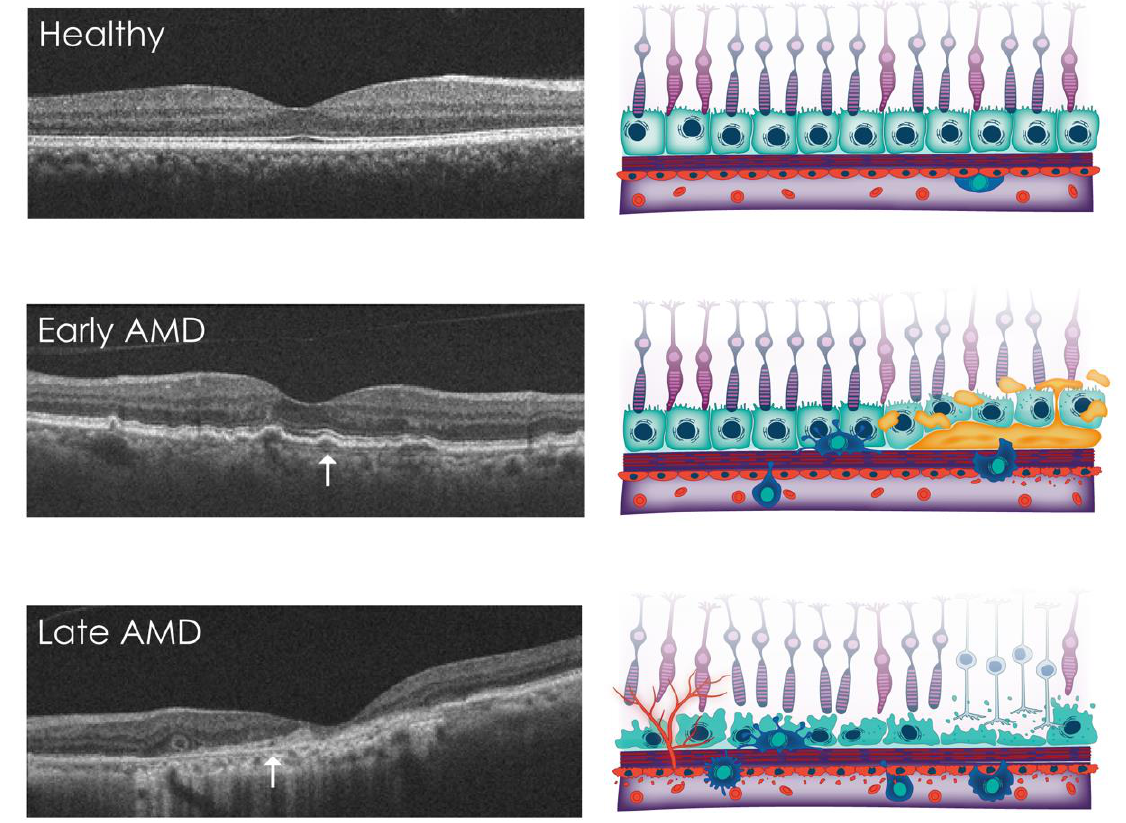
Figure 3. Pathological changes at the BrM interface in AMD. In healthy individuals ( top panels ), the retinal tissues are in a state of metabolic equilibrium. Early/intermediate AMD ( middle panels ) is characterised by the accumulation of extracellular deposits (illustrated in orange), such as soft drusen/BLinDs beneath the RPE and subretinal drusenoid deposits above it. These deposits mainly consist of lipoproteins of dietary and photoreceptor outer segment origin and are excreted by the RPE. They accumulate in the sub-RPE space and impede transit to the choroid due to ageing of the Bruch’s membrane. The accumulation of these deposits is associated with underlying choriocapillaris vascular dropout and initiates an immune response that leads to the recruitment of inflammatory cells. These deposits increase the risk of advanced stages of AMD, including atrophy and neovascularisation ( bottom panels ). Notably, BrM is more visible in areas of RPE separation and choroidal neovascularisation (white arrows). Changes within the Bruch’s membrane are not depicted in this figure. Open-source images used with permission [88]. Abbreviations: AMD, age-related macular degeneration; BLinDs, basal linear deposits; BrM, Bruch’s membrane; RPE, retinal pigment epithelium.